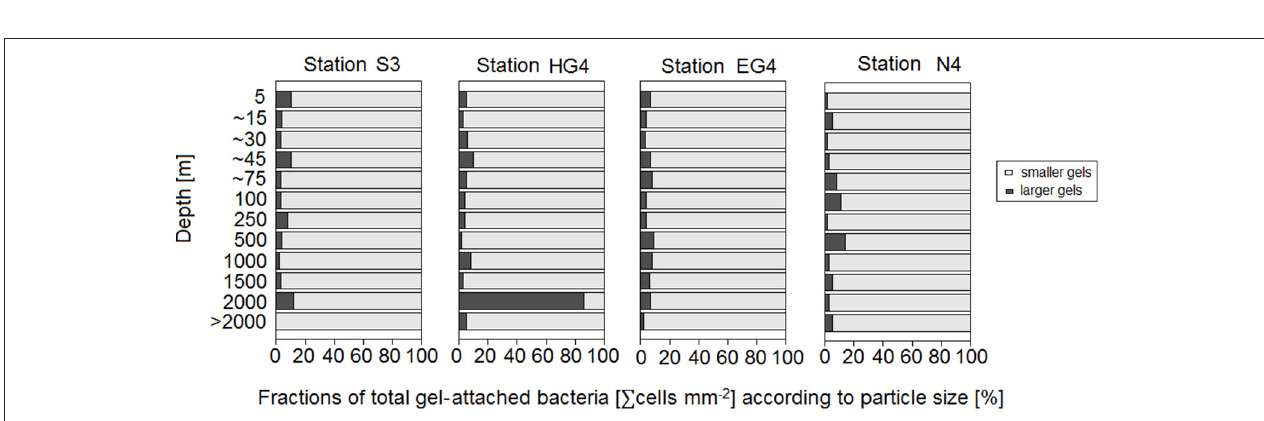
FIGURE 7 | Size (of particle )-frequency (of bacteria )-distributions for all four stations and both gel particle classes on a log-log scale. For all 12 sampling depths both replicates are plotted (black dots and white dots indicate replicate A and replicate B, respectively).